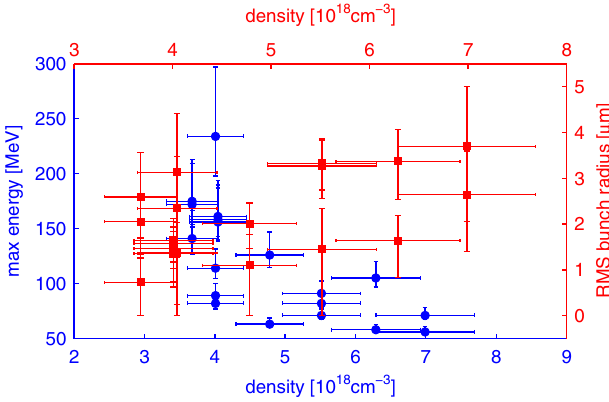
FIG. 3. Maximum electron energy (blue circles, left) and 1 =e 2 electron bunch radius (red squares, right) as a function of density. Horizontal error bars are (cid:2) 10% due to uncertainty in density determination and vertical error bars are due to uncer- tainty in electron beam pointing into spectrometer (4 mrad) and x-ray source size determination (95% confidence interval [20]). Each data point represents a single shot.